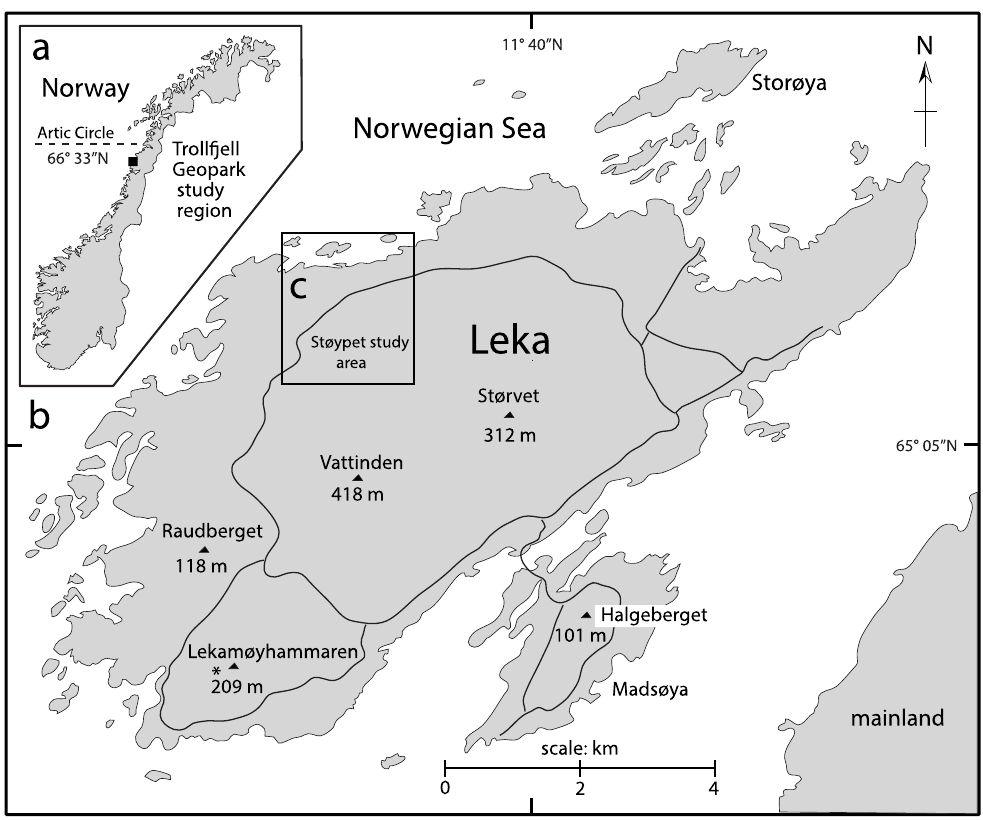
Figure 1. The west coast of Norway and Leka Island: ( a ) Norway, showing latitude of the Arctic Circle and region of the Trollfjell Geopark, ( b ) Leka Island and Madsøya with details on highland peaks and location of the Leka maiden monolith (asterisk), and ( c ) inset showing location the Støypet study site.